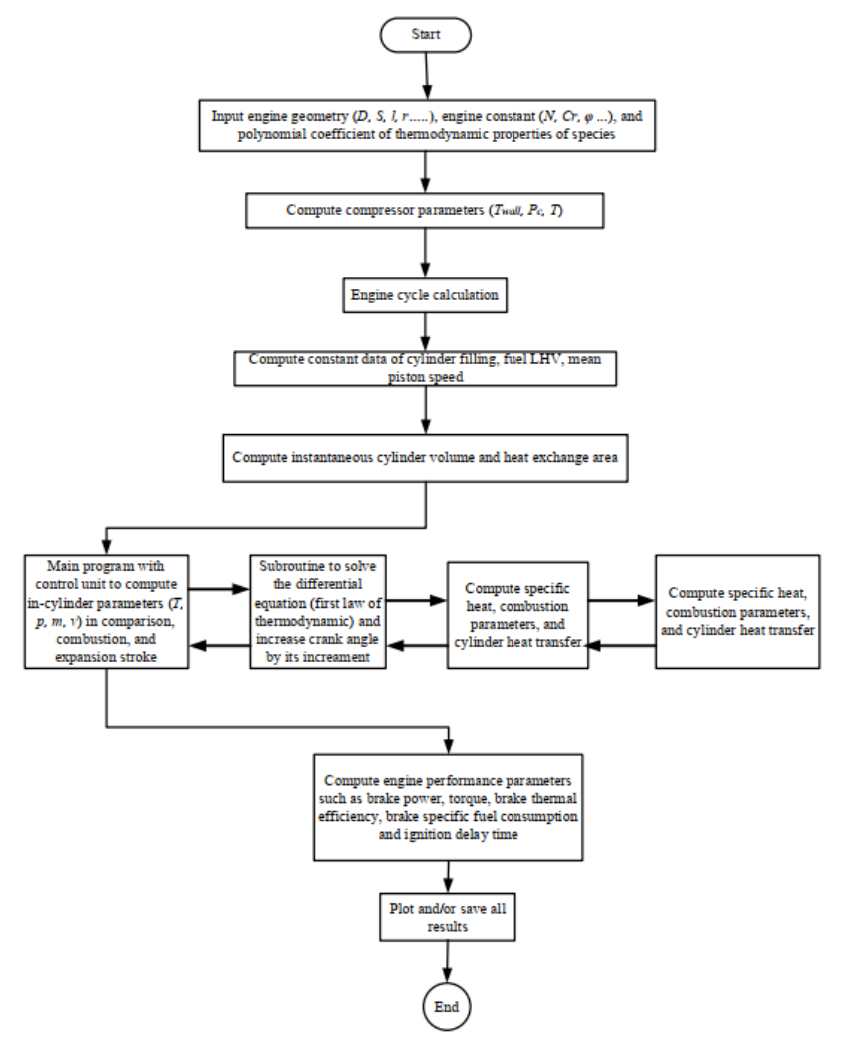
Figure 1. Methodology of simulation process used in the current study.